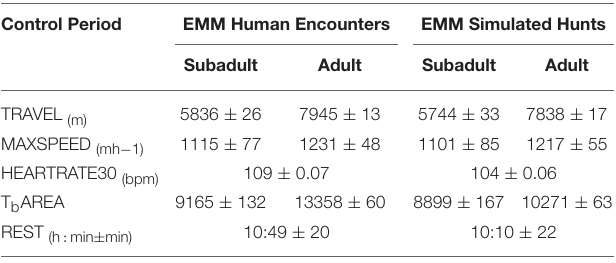
TABLE 2 | Estimated marginal means (EMM) for the control periods of the human encounters and the control periods of the simulated hunts. Control